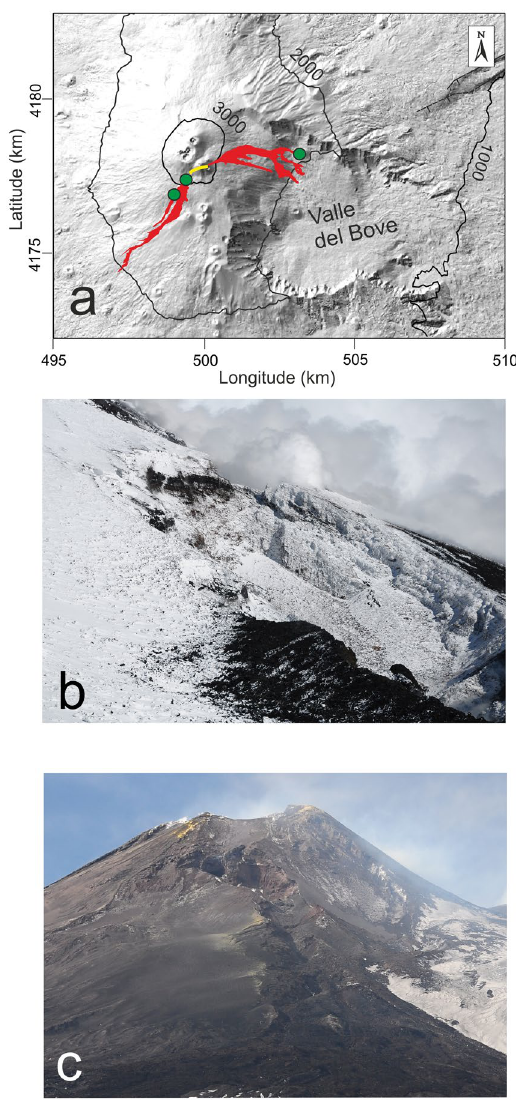
eastern branch of the eruptive fracture (~3050 m a.s.l.). Figure ( a ) was generated using CorelDRAW graphic suite software (http://www.corel.com/it/). The topography is based on a DEM held by INGV-OE,